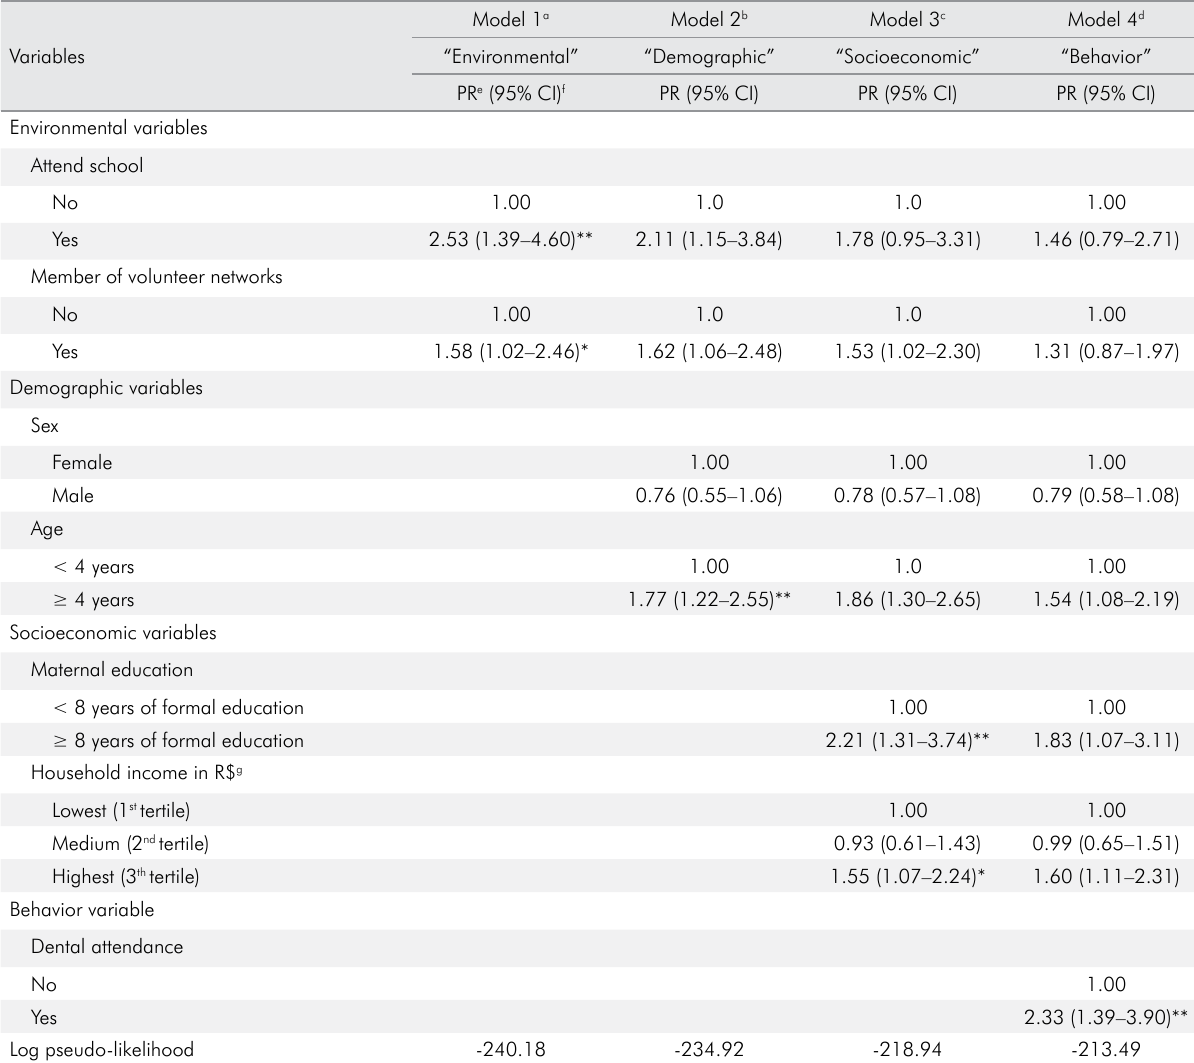
Table 3. Adjusted association of variables with use of dental floss, determined using Poisson regression with robust variance.